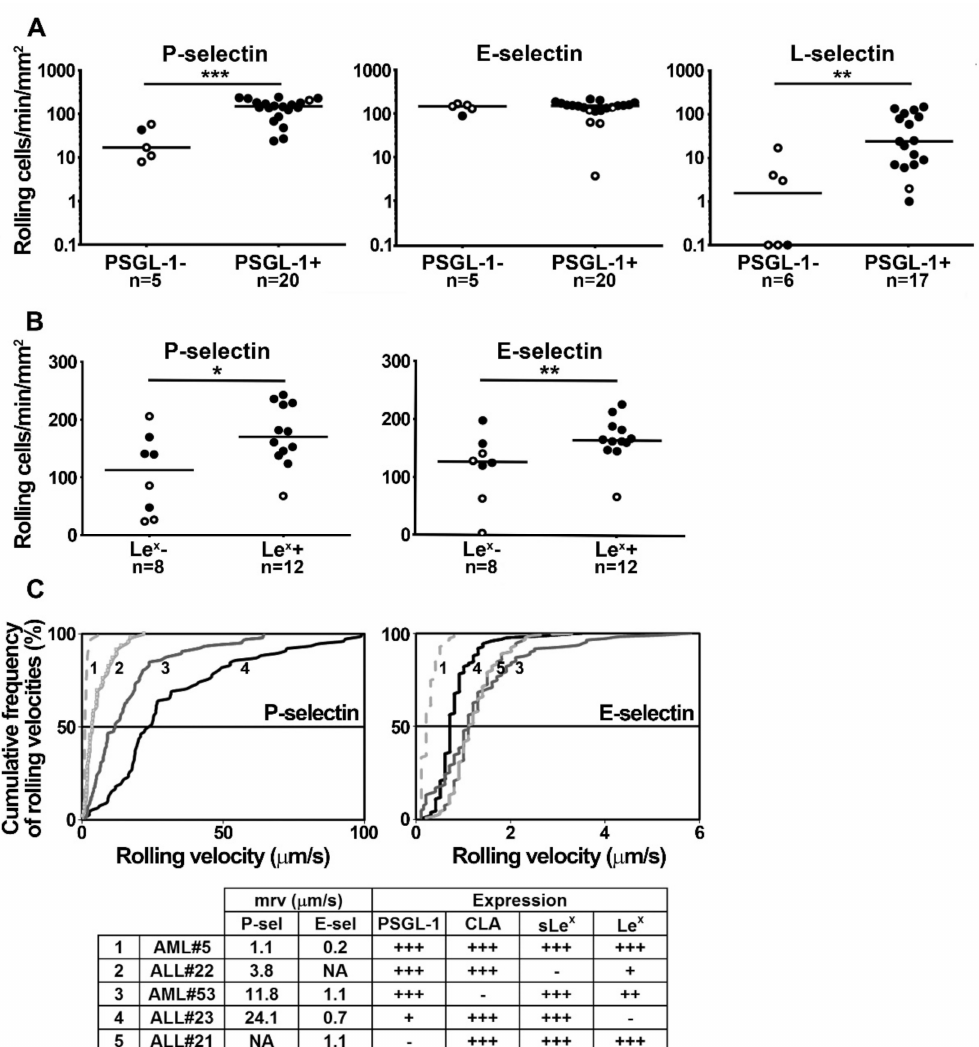
Figure 2. Impact of P-selectin glycoprotein ligand-1 (PSGL-1) and Lewis x expression on blast cell recruitment on selectins. Blast cells were perfused at 1.5 dyne / cm 2 on recombinant selectins adsorbed on a coverslip bound to the bottom of the flow chamber. Each assay was performed with a cell